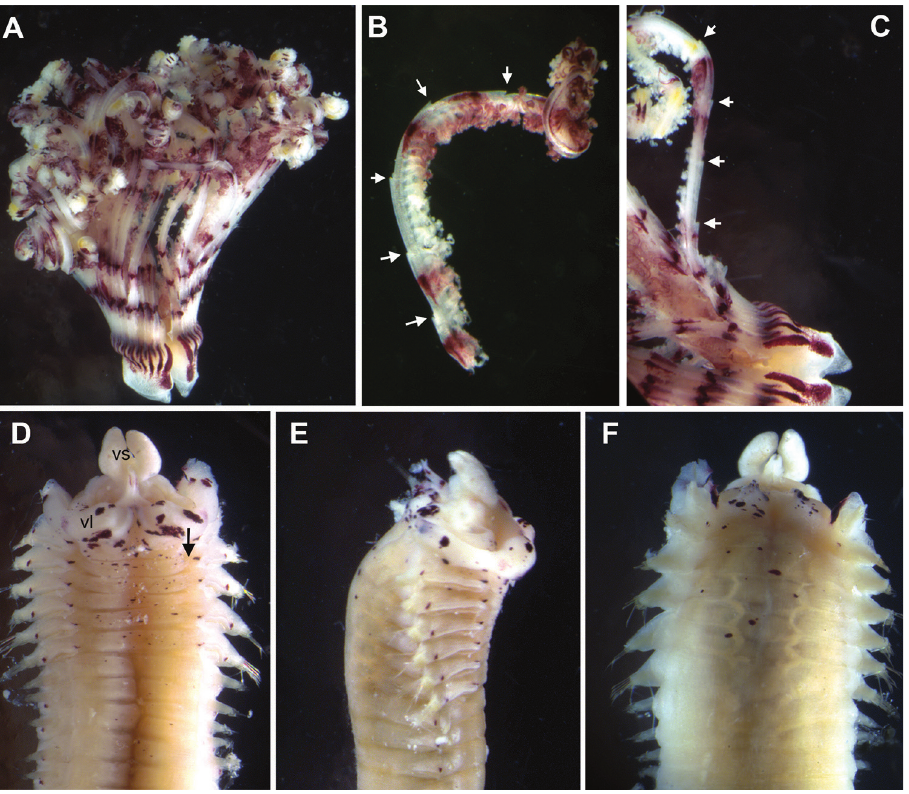
Figure 2. Pseudobranchiomma cf. P. emersoni AM W.36365; photographs of preserved specimen; A Ra- diolar crown, dorsal view B Detached radiole C Detail of base of crown and single radiole D Anterior segments, ventral view (crown detached) E Same, lateral view F Same, dorsal view. vl, ventral lappet; vs, ventral sacs; white arrows, serrations of radiolar lateral flanges; black arrow, gap between ventral shields and thoracic